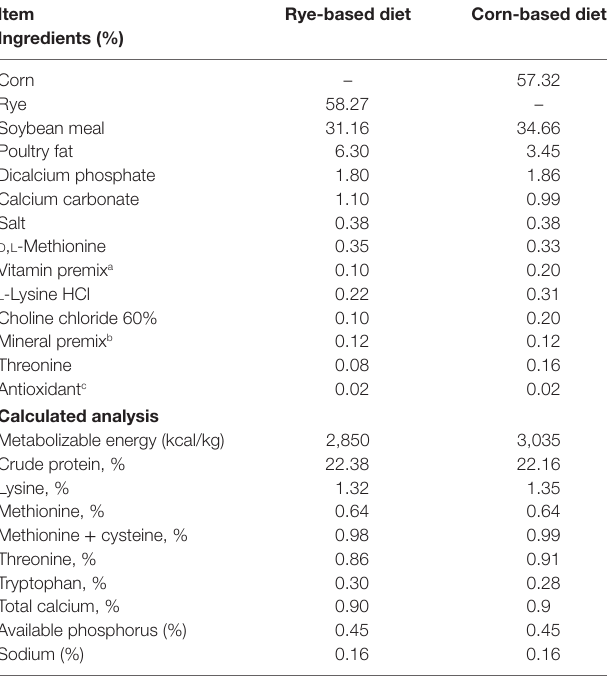
TaBle 1 | Composition and nutrient content of the experimental diets